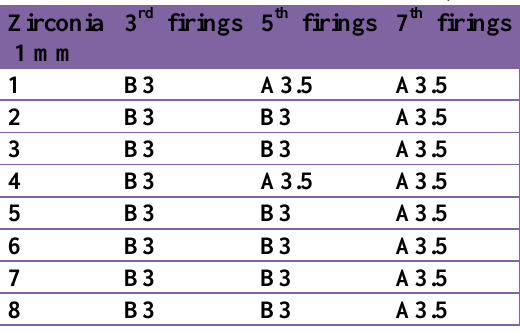
Table 2: Shade results of group A